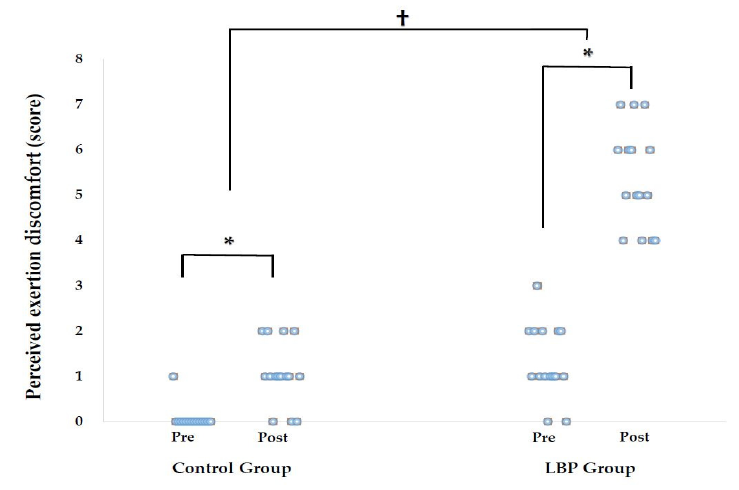
Figure 2. Mean of perceived discomfort after prolonged sitting with slumped posture. * Significant differences between pre and posttest ( p < 0.05). † Significant differences between the group ( p < 0.05).